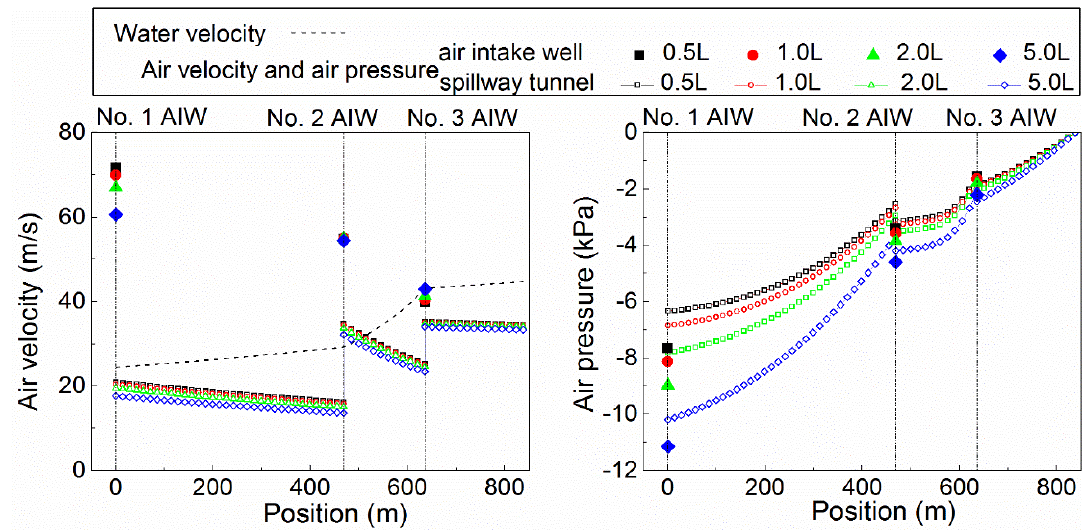
Figure 13. Influence of the length of air intake wells on the ventilation characteristics.